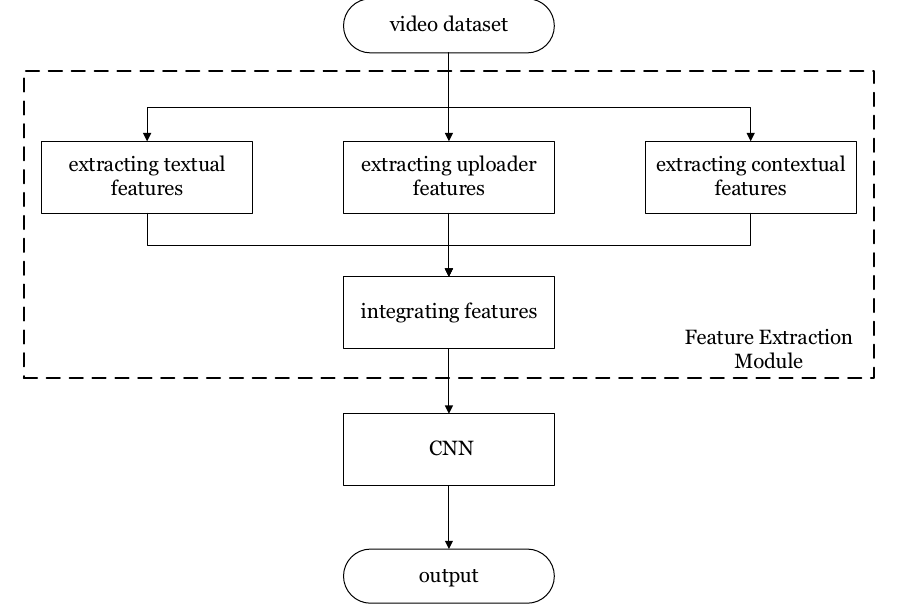
Figure 2. The CNN-based misleading video detection model.